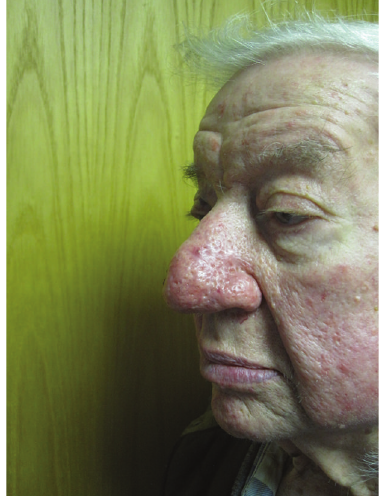
Figure 12: Case 3, three week postoperative